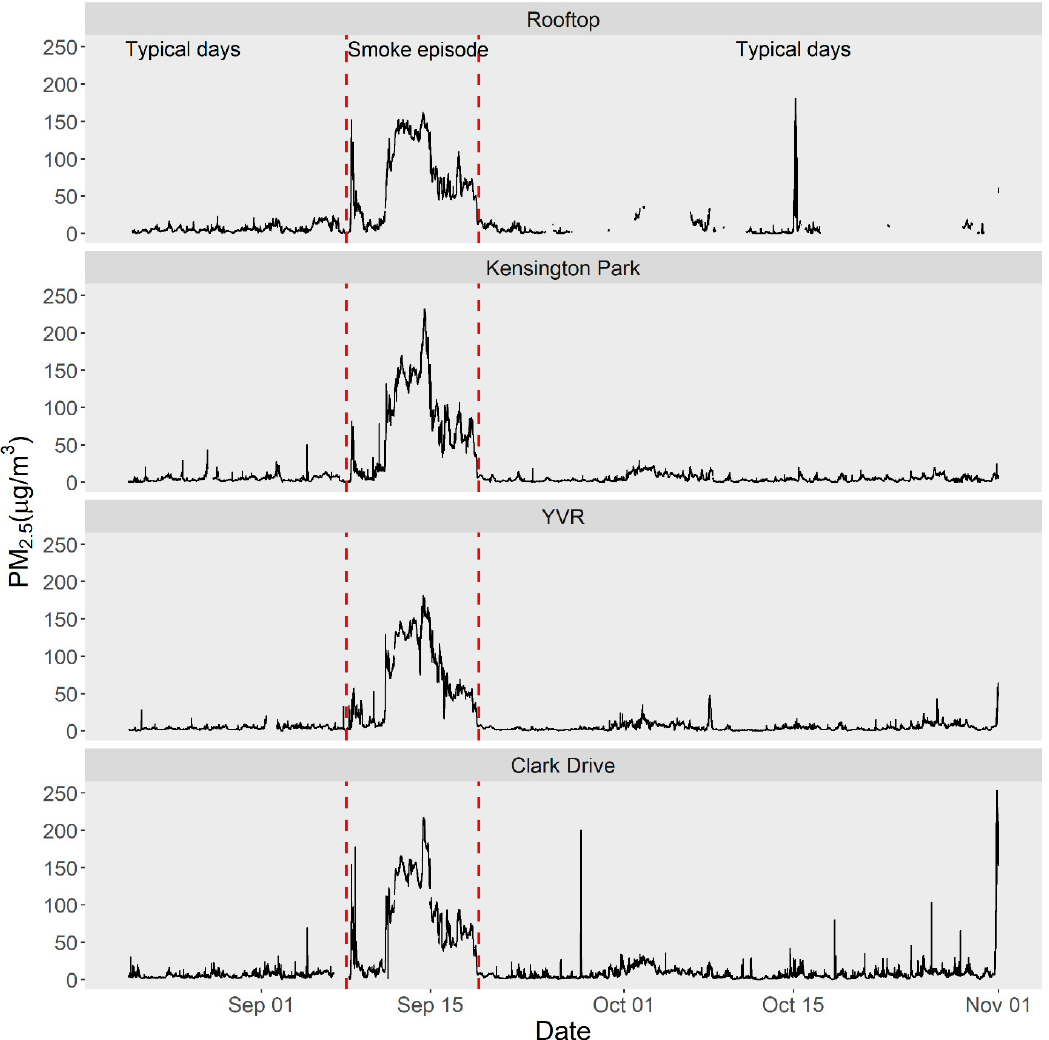
Figure 3. Time series of raw 1-min PM 2.5 concentrations from the low-cost sensors located outdoors on the rehabilitation facility rooftop and from beta attenuation monitors at three national air pollution surveillance (NAPS) monitoring stations at Kensington Park, Vancouver International Airport (YVR) and Clark Drive in greater Vancouver, Canada (Figure 2).